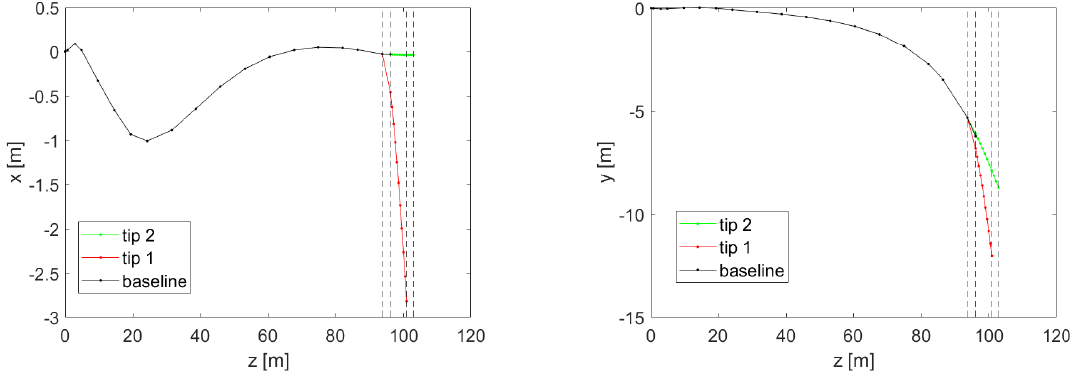
Figure 2. Blade centerline for two reference tips at the borders of the design space. Vertical dashed lines indicate the location of the control